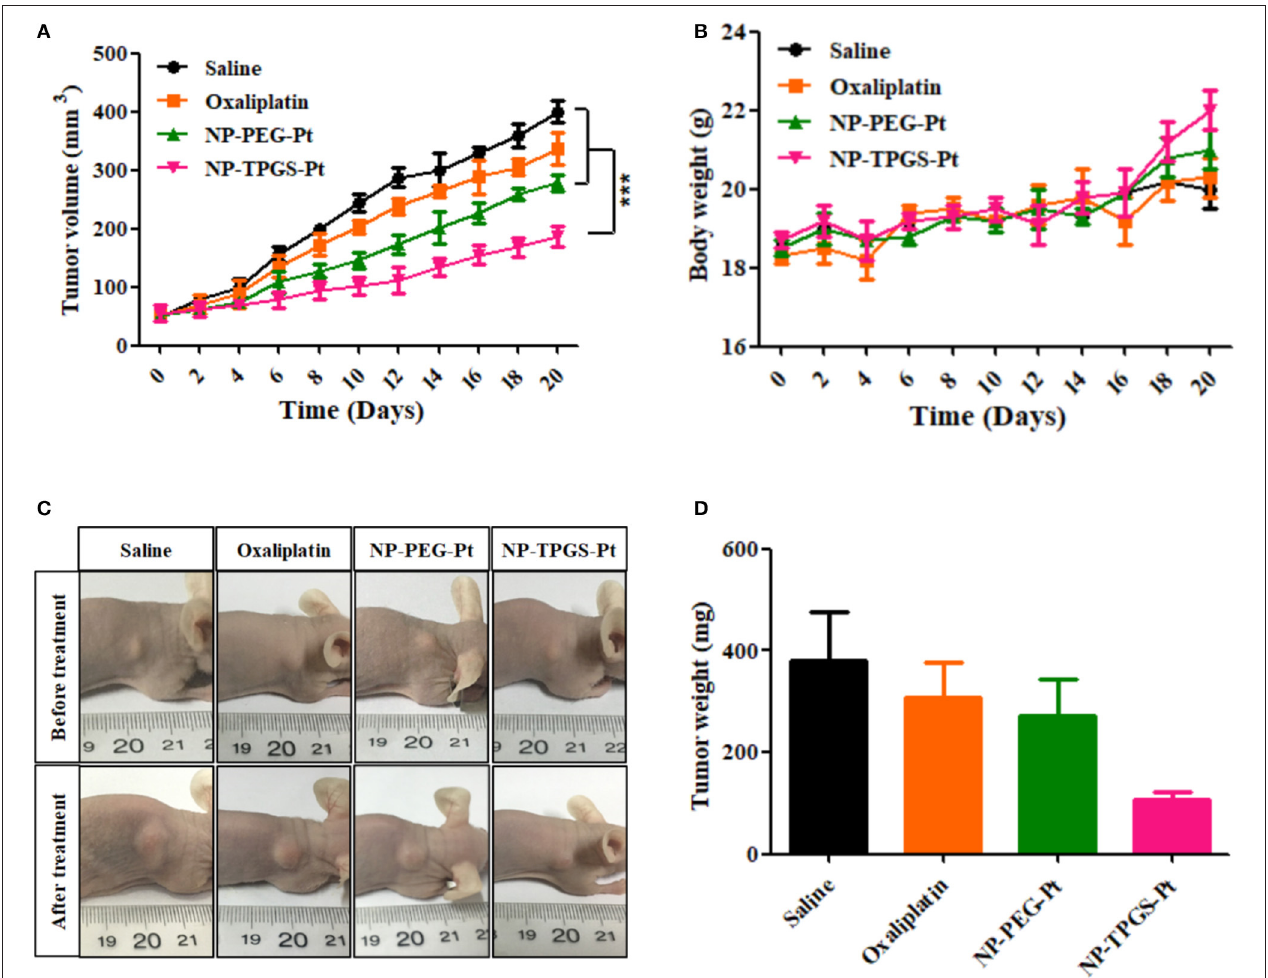
FIGURE 8 | Influence of DACHPt formulations on antitumor effects (A) , and changes of body weight (B) of A549/DDP xenograft-bearing nude mice. Images (C) and weights (D) of tumors resected from each group of sacrificed mice on the last